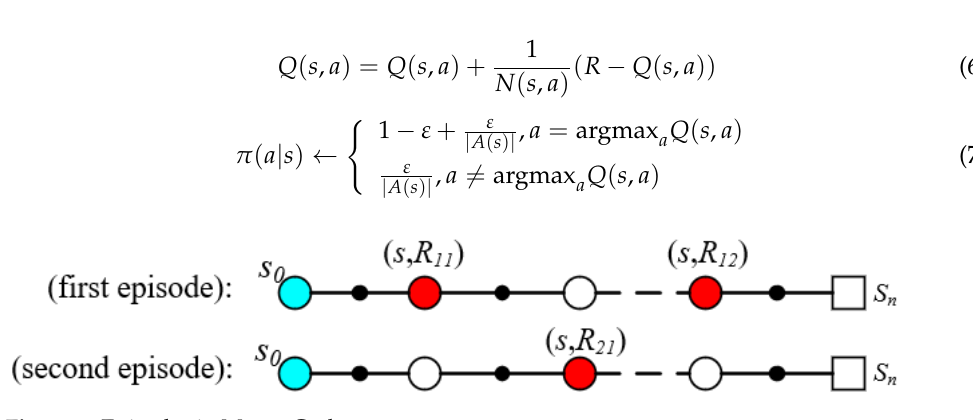
Figure 6. Episodes in Monte Carlo.